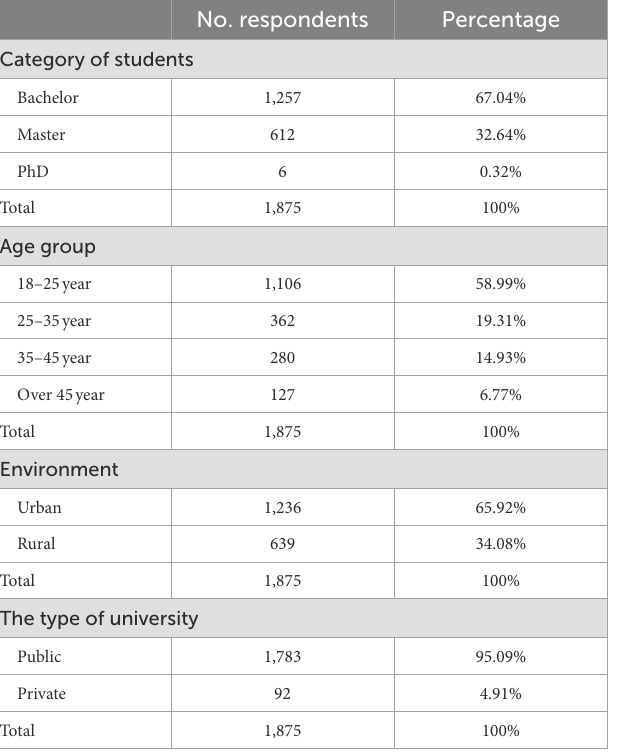
TABLE 1 Demographic results regarding students involved in the study. TABLE 2 Factor loadings and items’